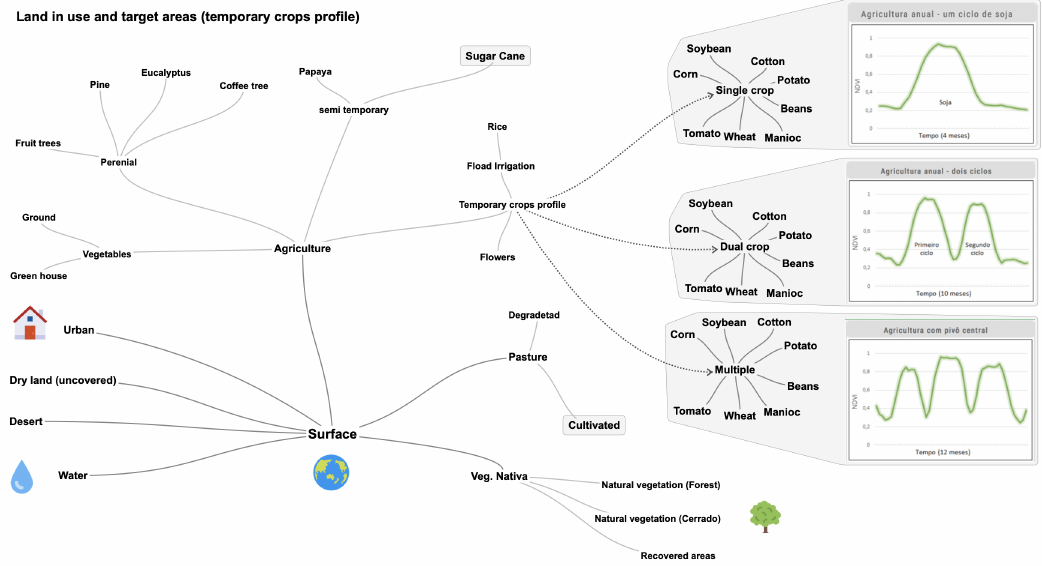
Figure 2. A concept map of the ontology used—Target groups highlighted above share seasonal characteristics with each other and within the time frame selected from EVI collected maps. Sources: EMBRAPA, MODIS,